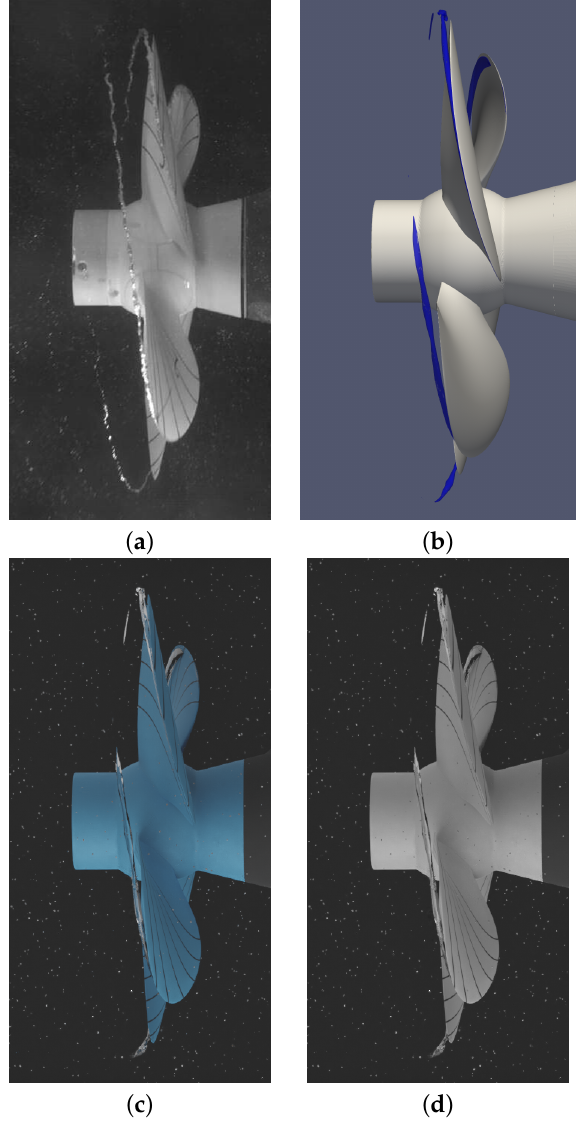
Figure 12. C4-70 propeller exhibiting tip vortex cavitation. ( a ) Experimental, ( b ) ParaView, raster- isation, ( c ) Blender, ray tracing in colour, and ( d ) Blender, ray tracing in black-and-white. Flow is from right to left. Propeller rotates in a clockwise direction when viewed from behind. Free-surface extracted using a vapour volume fraction iso-contour of